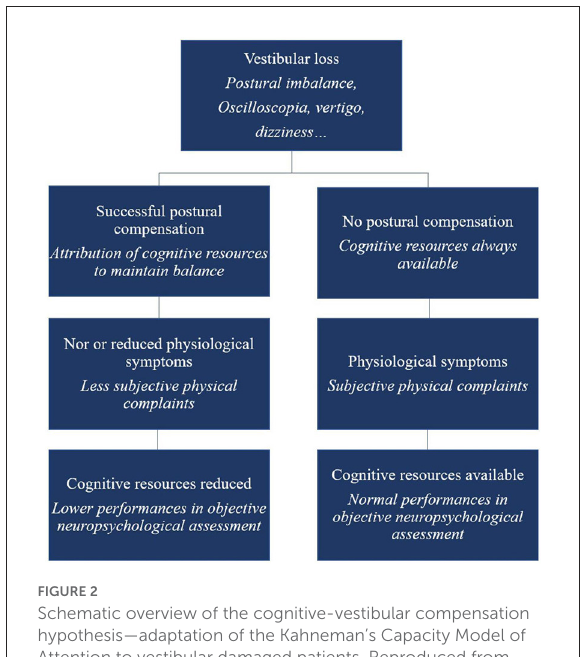
FIGURE2 Schematic overview of the cognitive-vestibular compensation hypothesis—adaptation of the Kahneman’s Capacity Model of Attention to vestibular damaged patients. Reproduced from Lacroix et al.